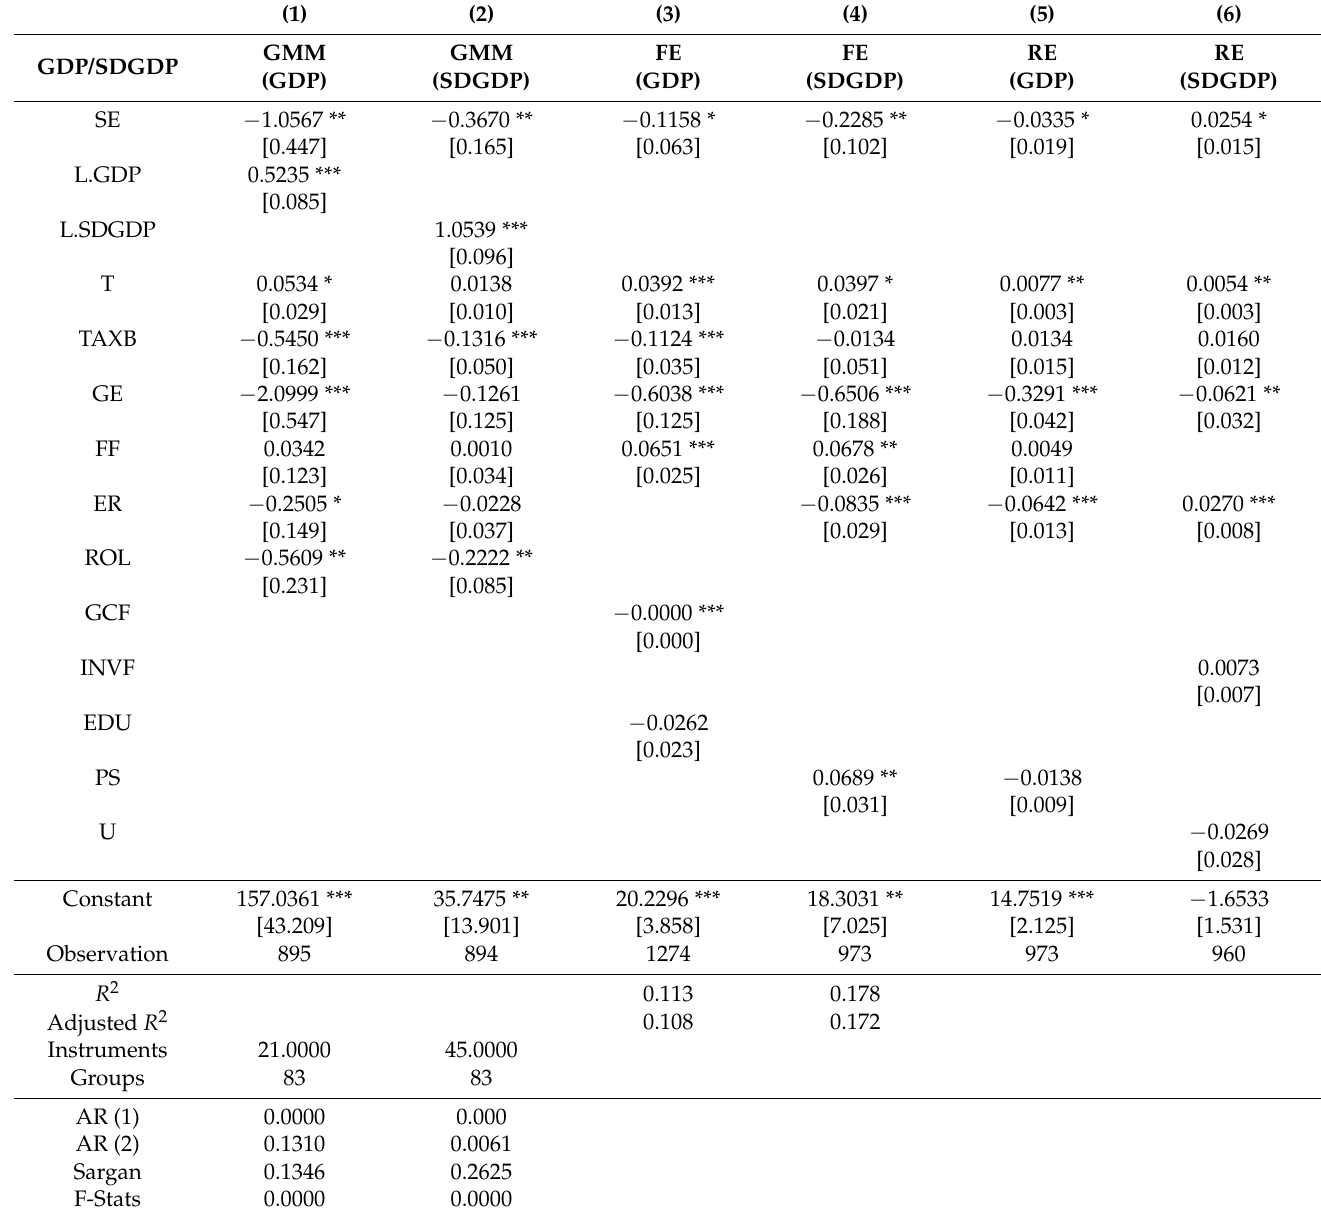
Table 3. Impact of shadow economy on economic